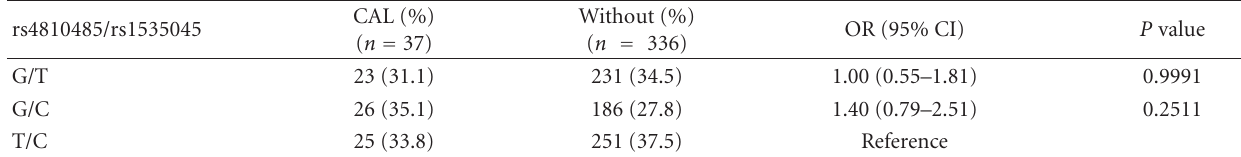
Table 5: Haplotype frequencies of the CD40 gene in patients with or without coronary artery lesion